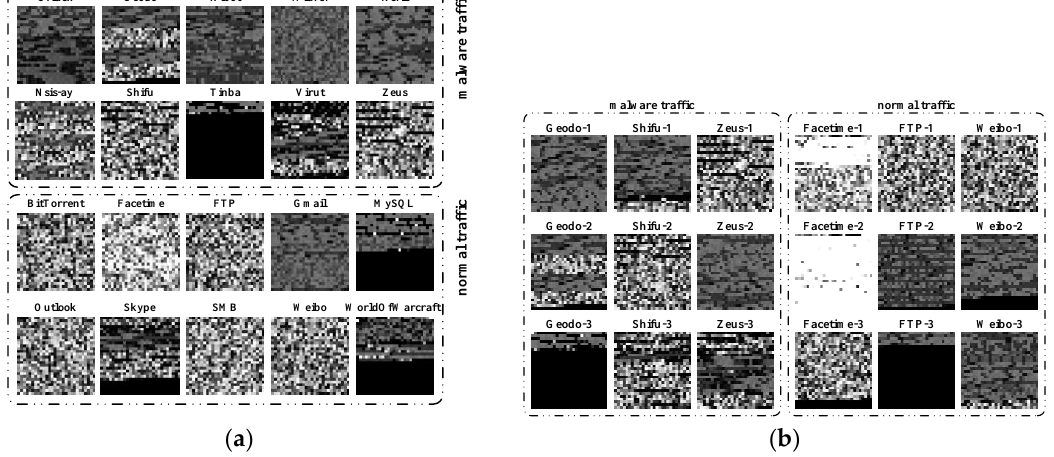
Figure 6. ( a ) Random selection of gray images for each kind of network traffic; ( b ) Carefully selected sets of grayscale images for several kinds of network traffic.